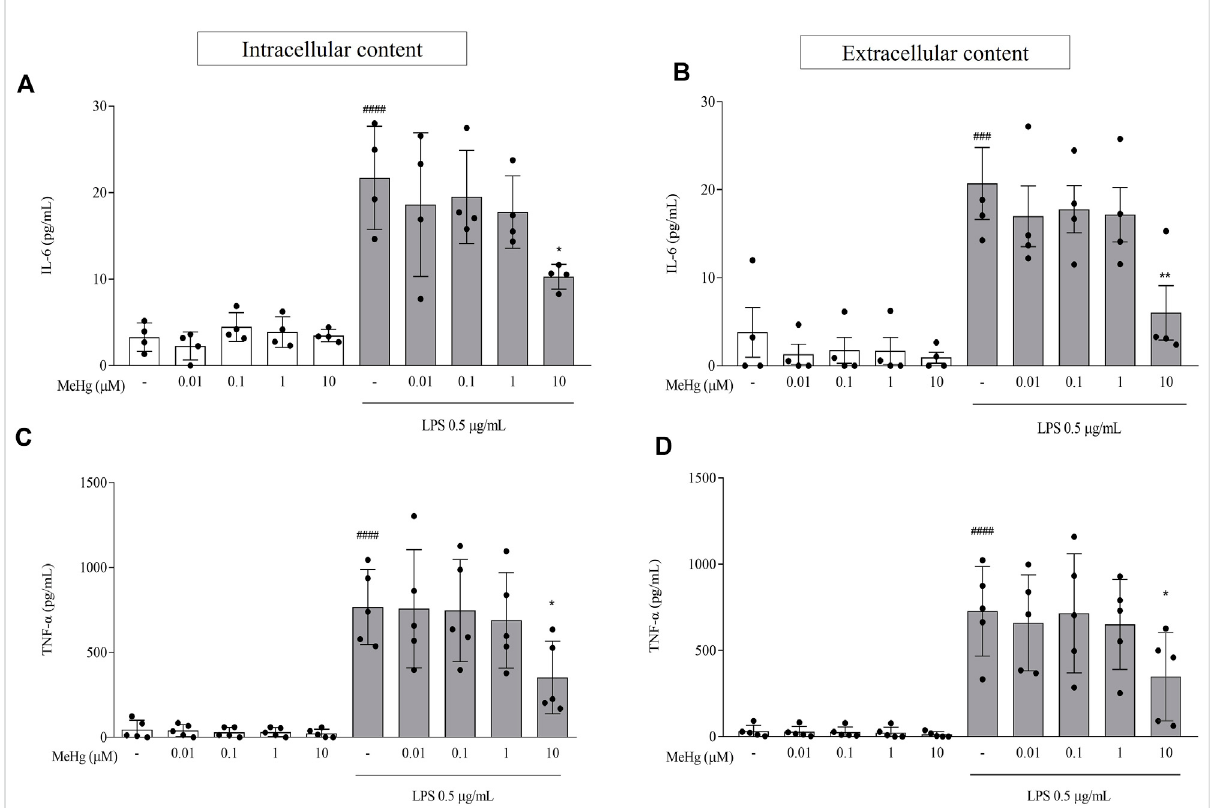
FIGURE 2 Effects of MeHg exposure (0.01, 0.1, 1, and 10 µM), on IL-6 and TNF- α contents using ELISA assay. (A) IL-6 and (C) TNF- α intracellular contents and (B) IL-6 and (D) TNF- α extracellular contents were quanti fi ed after exposure to different MeHg concentrations on BV-2 microglial cells treated for1 handsubsequentlystimulatedwithLPSfor6 h### p < 0.001and#### p < 0.0001vs.Control;* p < 0.05vs.LPS.DataareexpressedasMean± SEM. (A) and (C) n = 4 and (B) and (D) n = 5. One-way ANOVA, followed by Bonferroni ’ s multiple comparisons